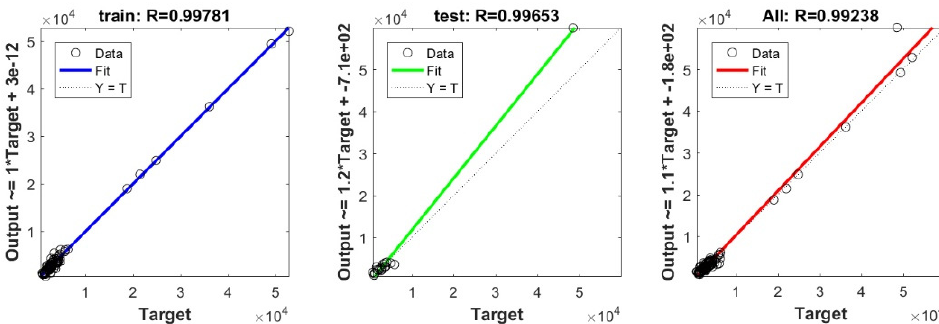
Figure A4. Scatter plots between target and output values by the GP model.